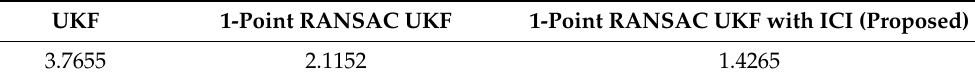
Table 2. Specification of the sensors.